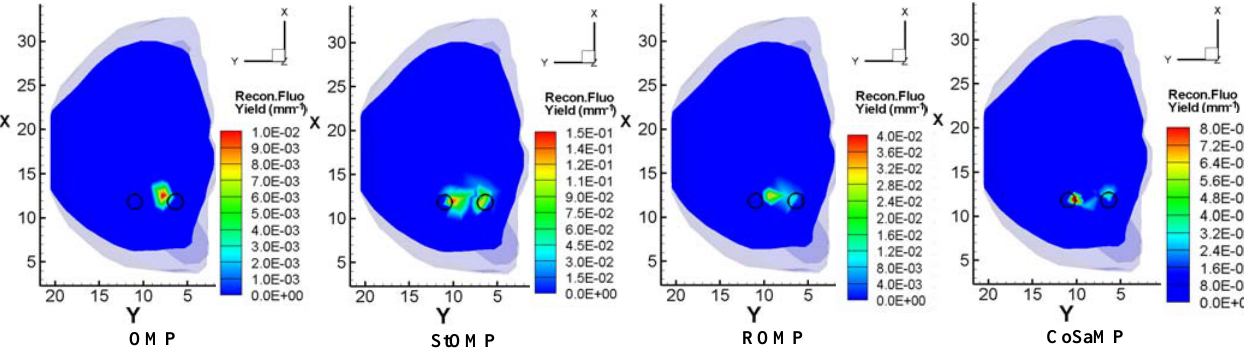
Fig. 5. Reconstruction results in the case of two targets with di®erent °uorescence yields. The true °uorescence yields of the two targets are 0.10 mm (cid:2) 1 and 0.05 mm (cid:2) 1 ,